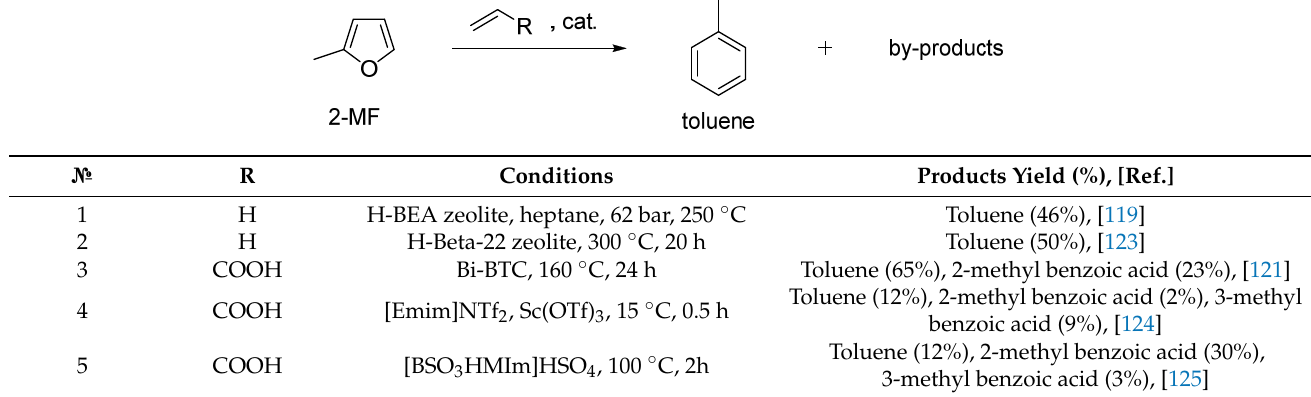
Table 8. Synthesis of toluene by DA reaction of 2-MF with alkenes.